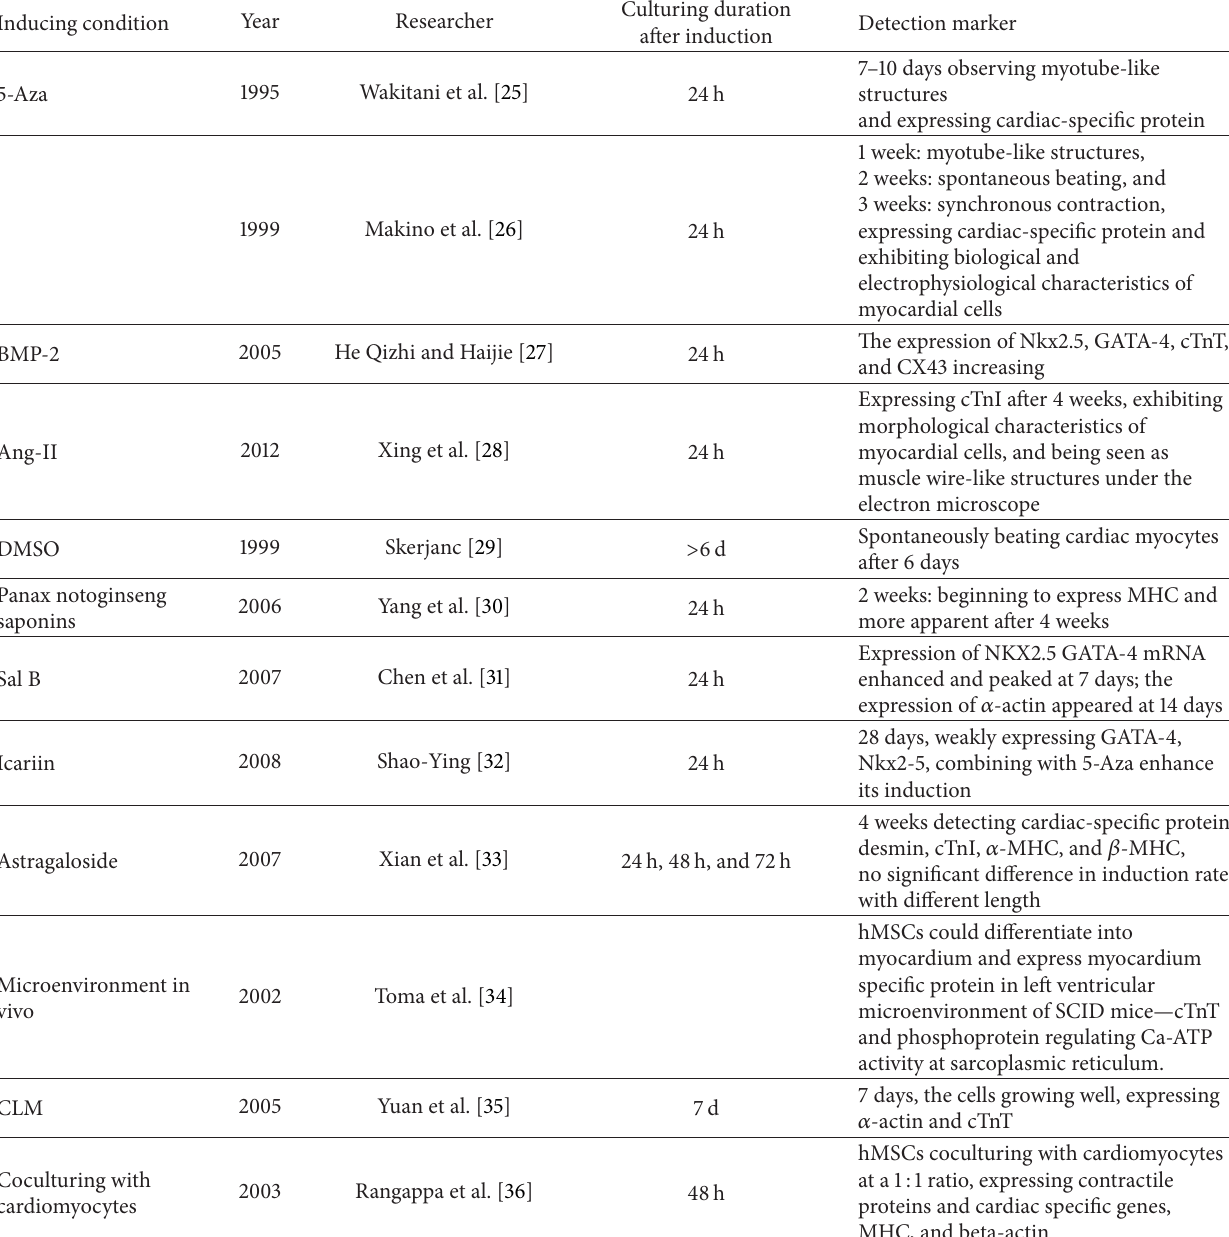
Table 1: The inducer for BMSC